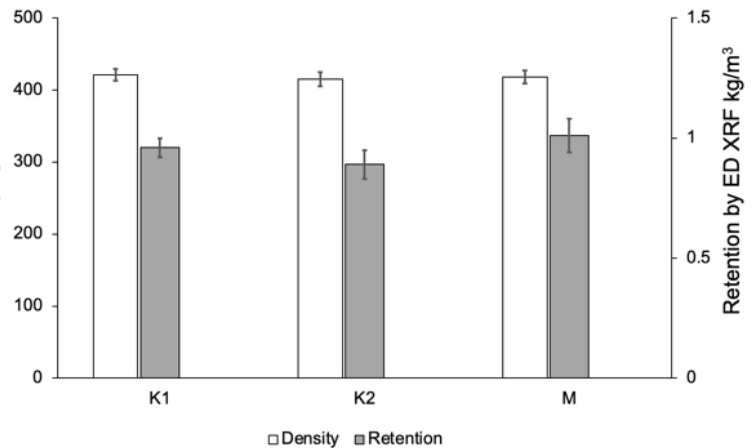
Figure 1. Density (primary axis) and Retention by ED XRF (secondary axis) of radiata pine wood impregnated with K1, K2 and M. The maximum standard error for density was 10 kg/m 3 and 0.07 kg/m 3 for ED XRF